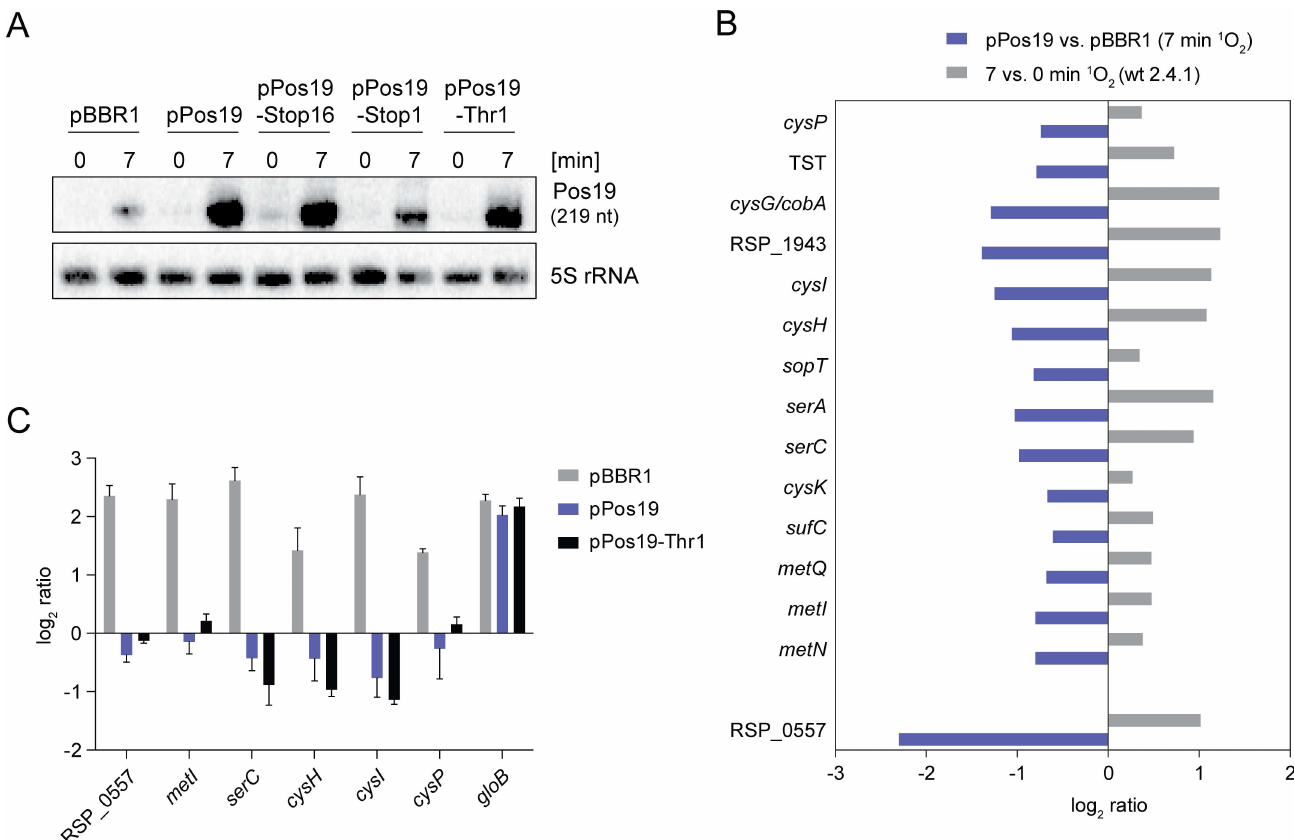
Fig 3. Genes involved in sulfur metabolism are repressed by Pos19 upon 1 O 2 stress. (A) Plasmid-borne over-expression of Pos19. The pos19 gene together with its native RpoE-dependent promoter was clonedinto middle-copy plasmid pBBR1 and expressedin R . sphaeroides wild-type 2.4.1 cells (pPos19). Additionally, Pos19 was over-expressed with mutations in codon 16 and start codon 1 (Fig 2A). Wild-type cells carrying empty vector pBBR1 served as a control (pBBR1). Strains were subjected to 1 O 2 stress experiments and samples (collected at 0 and 7 min) used for Northern blot analysis. The 5S rRNA was probed as a loadingcontrol. (B) Microarray results for genes involvedin sulfur metabolism and the most down-regulated mRNA RSP_0557. Samples from the Pos19 over-expression strain (pPos19) were collected after 7 min of 1 O 2 stress and compared to an empty vector control (pBBR1) by microarray analysis (blue bars). In a second microarray analysis, samples from stressed R . sphaeroides wild- type 2.4.1 cells (7 min 1 O 2 ) were compared to unstressed cells (grey bars) [28]. Effects on mRNA levels were calculated as log 2 ratios. Values represent the mean from two individualmicroarray analyses, each containingpooledbiologicaltriplicates per strain. (C) Induction of selected genes by qRT-PCR. Empty vector control (pBBR1) and over-expression strains (pPos19 and pThr1) were subjectedto 1 O 2 stress experiments with samples collectedat time points 0 and 7 min of stress. Selected mRNA levels in stress samples (7 min) were calculatedrelative to unstressed samples (0 min) as log 2 ratios, using rpoZ as a control gene. Results were obtainedfrom three independent biologicalexperiments. Error bars represent the standard error of mean.